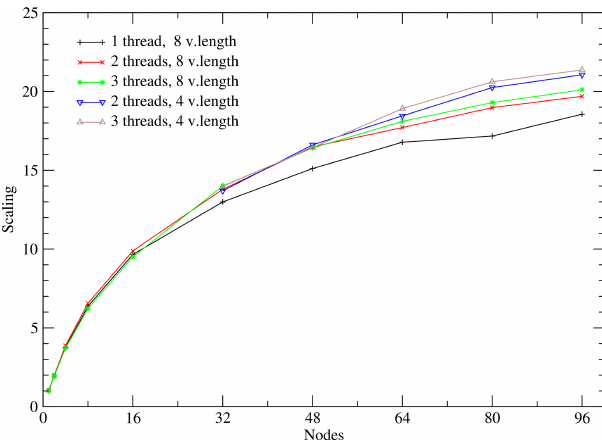
Figure 8. Scaling for the sequential 160km setups for different numbers of OpenMP threads and vector